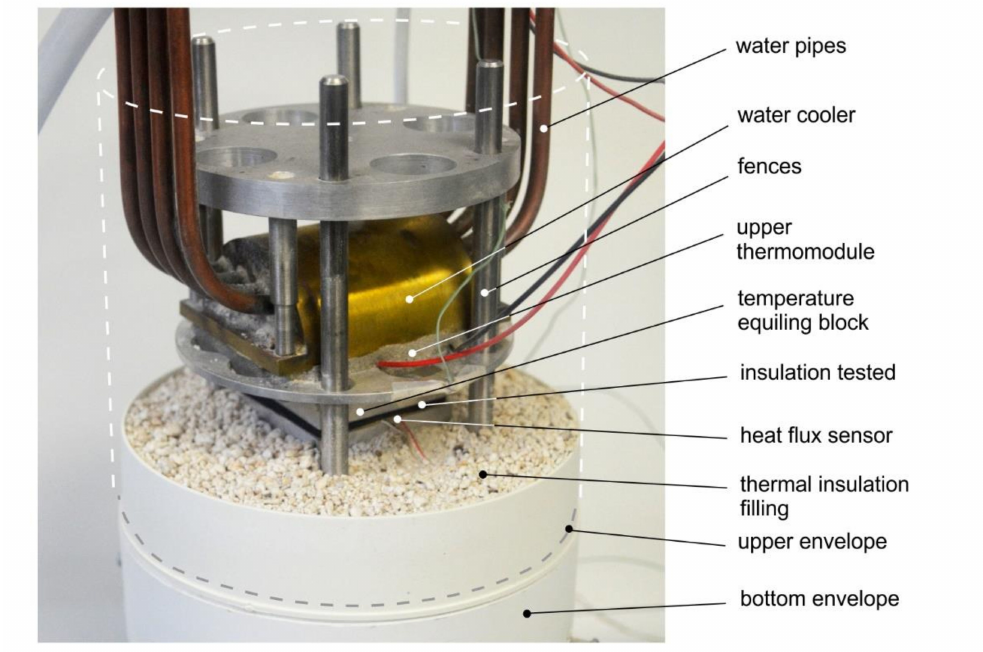
Figure 7. Photo of hot plate apparatus used by the authors (the upper envelope and insulation filling are removed for better